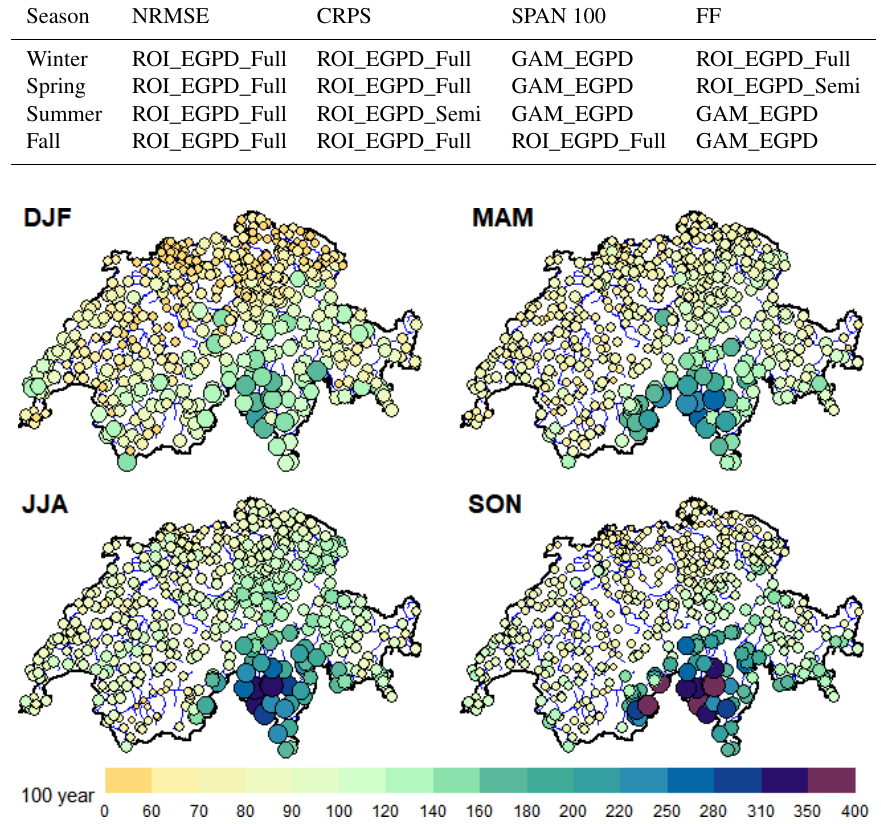
Figure 6. Map of Switzerland showing the 100-year return level for the four seasons as predicted with the ROI_EGPD_Full model.